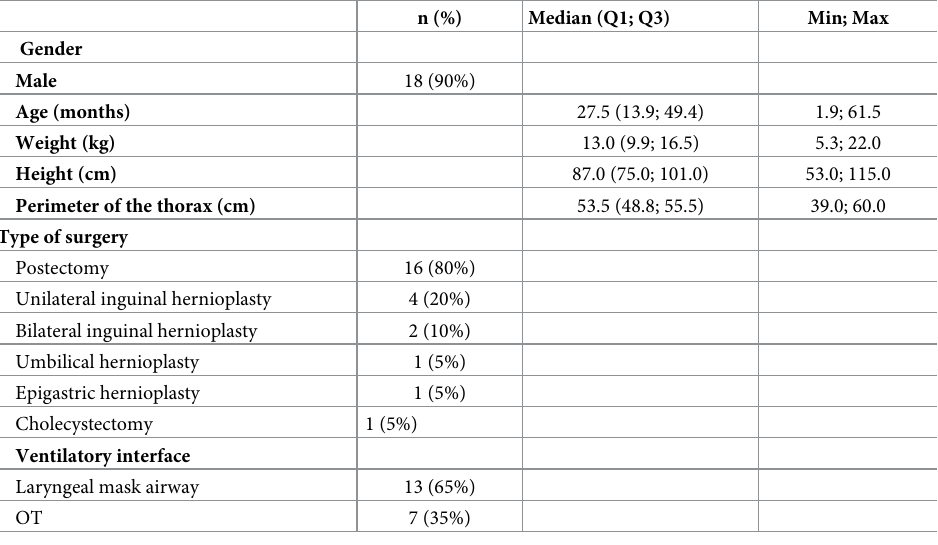
Table 1. Demographic characteristics of pediatric patients evaluated using EIT (n = 20).